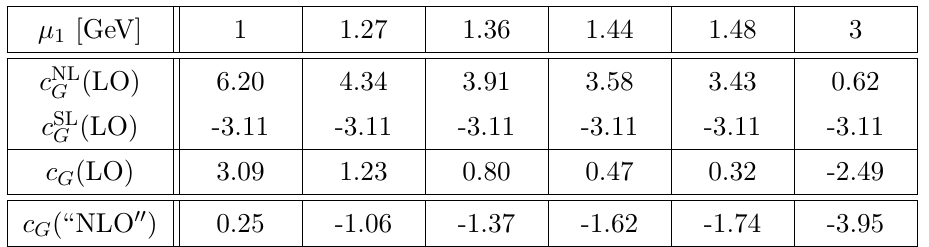
, c NL , and c = c SL + c NL for different values of the G G G G G = 1 . 5 c